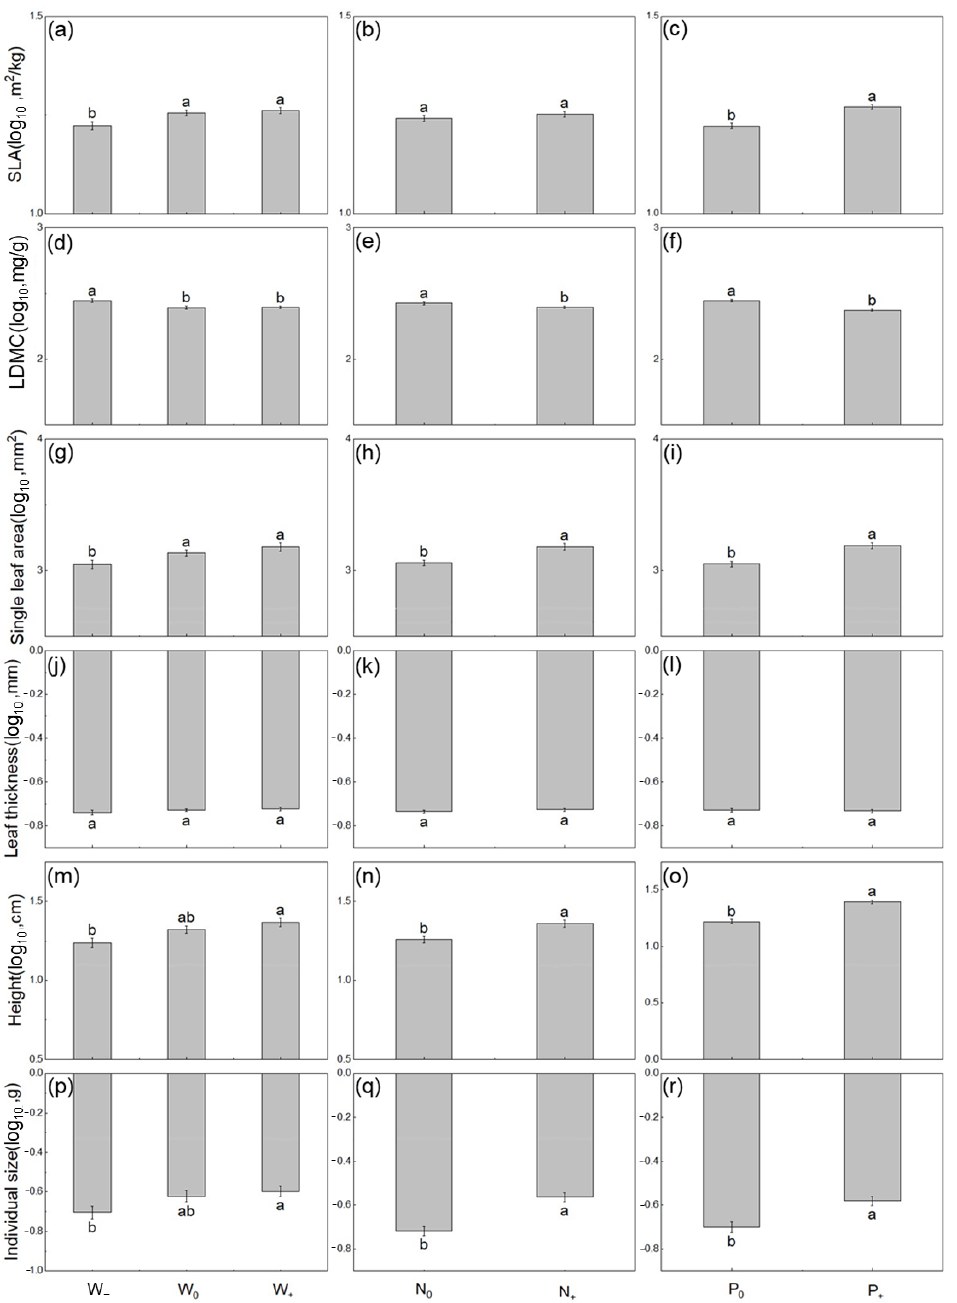
Figure 3. Traits under treatments of precipitation change ( a , d , g , j , m , p ), nitrogen ( b , e , h , k , n , q ) and phosphorus ( c , f , i , l , o , r ) additions. W 0 N 0 P 0 : control group; W + : 50% precipitation increase; W − : 50% rain reduction; N + : nitrogen addition; P + : phosphorus addition. Different lowercase letters in the figure indicate the significant difference of the mean value of traits under different treatments, and the Tukey’s HSD method or paired t -test (for two levels) was used to test the significance.